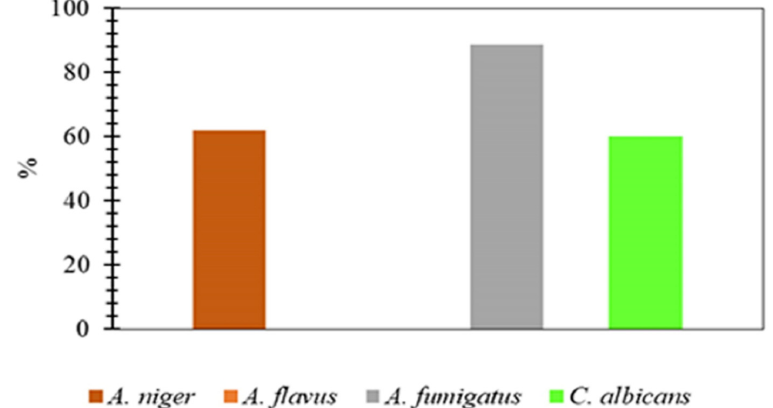
Figure 9. Antifungal Activity of Compound 3 Against Some Fungi.